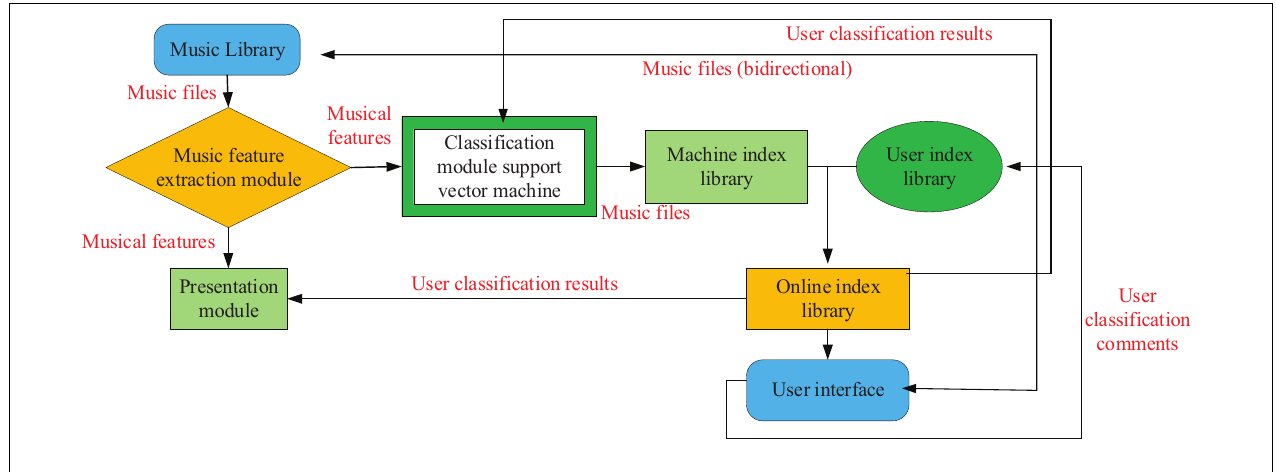
FIGURE 7 | The retrieval framework of differentiated music library platform.